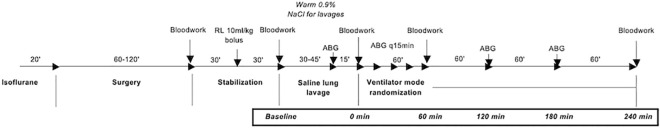
Timeline of experimental protocol.Baseline is at end of stabilization, and time 0 is at end of saline lung lavage with 60 min intervals afterwards ending at 240 min. Euthanasia and tissue harvesting occurred after 240 min collections. RL, Ringer’s Lactate; ABG, arterial blood gas.